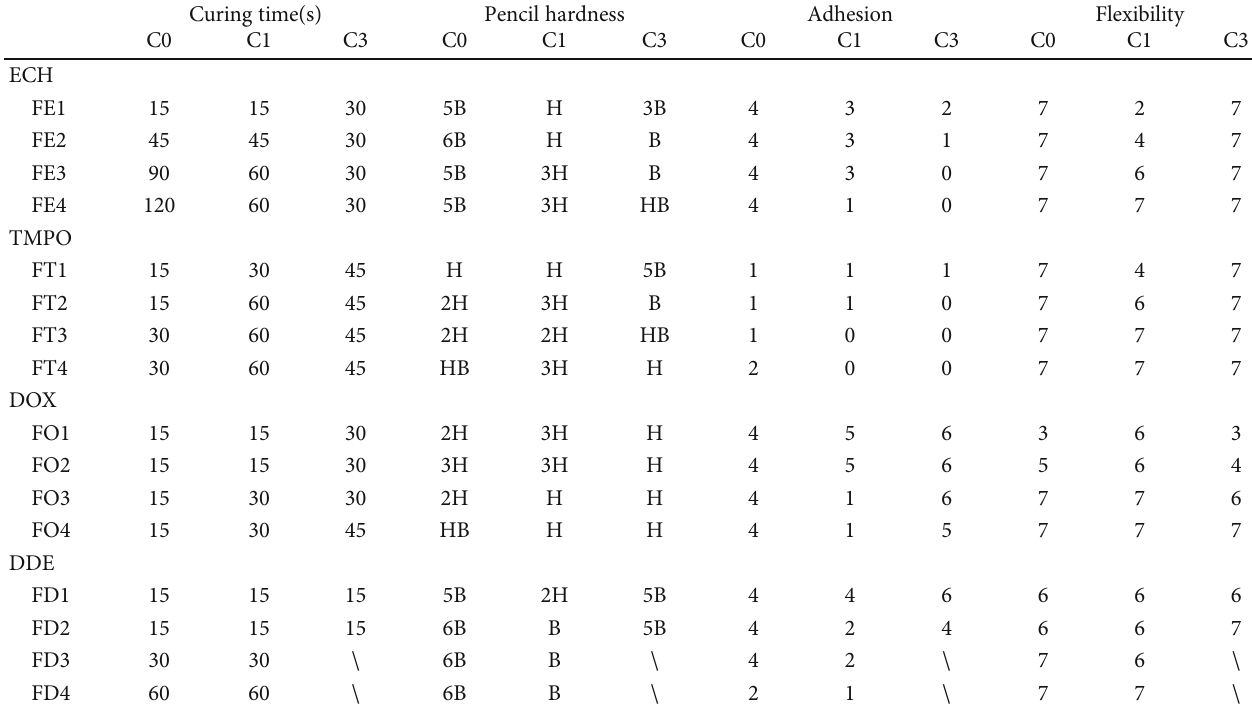
Table 2: E ff ect of di ff erent monomers on the mechanical properties of di ff erent fl uorinated prepolymers formulations. Curing time(s)